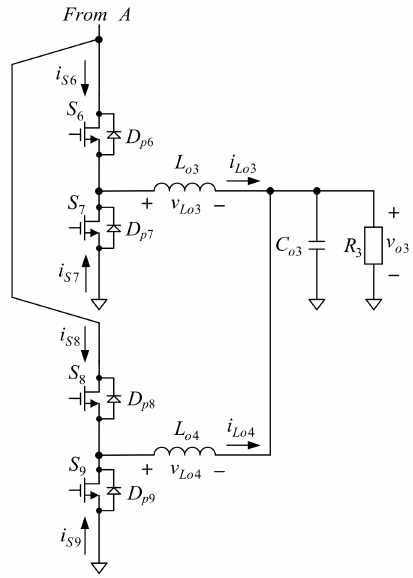
Figure 3. Two-phase interleaved SR buck